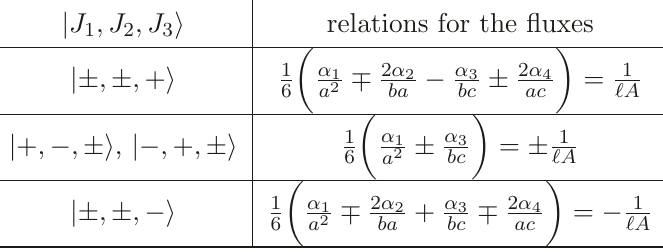
Table 3 . Decomposition of (3.34) into